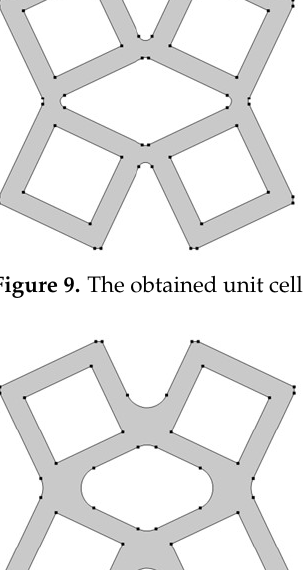
Figure 8. The obtained unit cell for fillet radius = 0.